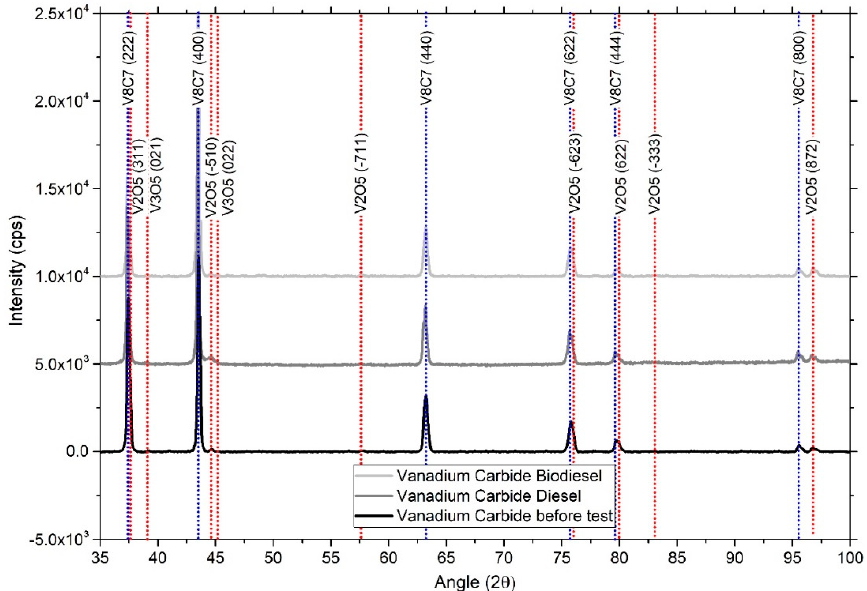
Figure 5. XRD spectrum of the VC coating before and after exposure to palm biodiesel at 1320 h in cyclic oxidation.